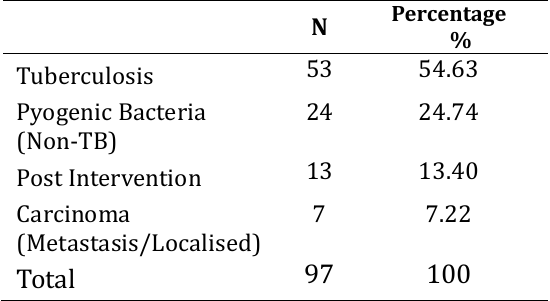
Table 2: Distribution of Aetiology of